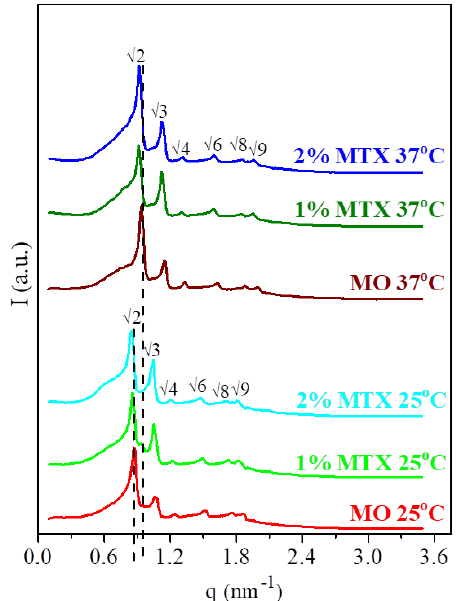
Figure 1. Comparison of SAXS spectra for the bulk cubic phases with 40% w/w of buffer and different amounts of MTX at 25 °C and 37 °C. Peaks are indexed for a double diamond cubic phase. The dashed lines show the position of the first peak for MO phase at 25 °C and 37 °C.